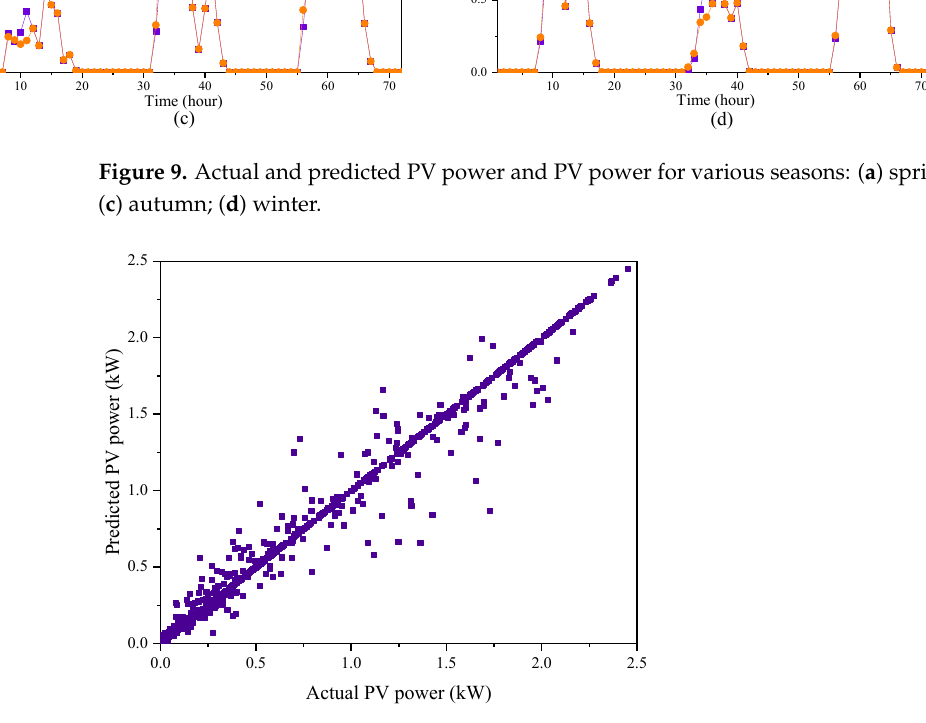
Figure 10. Correlation between actual and predicted PV power.